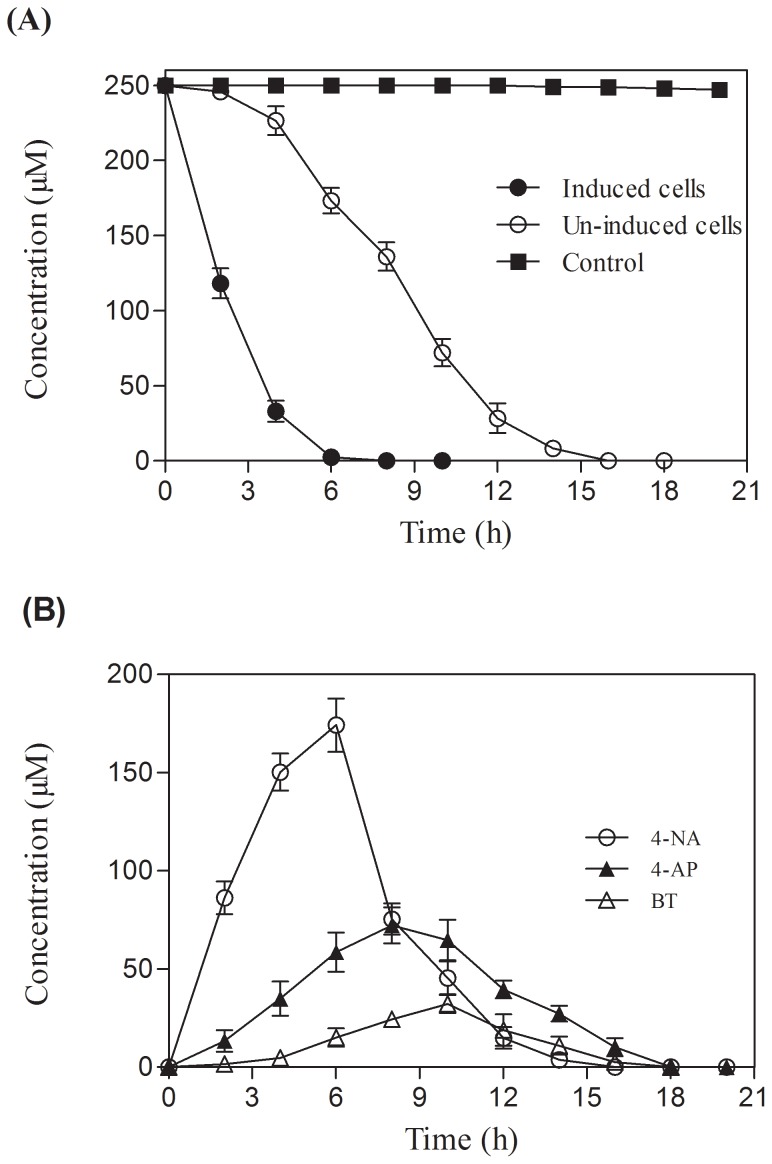
Kinetics of MNA degradation by MNA-induced and un-induced cells of strain FK357 and identification of MNA degradation intermediates.(A) Kinetics of MNA degradation. (•), MNA; (○), MNA; (▪), MNA in abiotic control. (B) Identification of MNA degradation intermediates. (○), 4-NA; (▴), 4-AP; (Δ), BT. Values are presented as arithmetic mean of data obtained from experiments carried out in triplicate; error bars represent standard deviation.